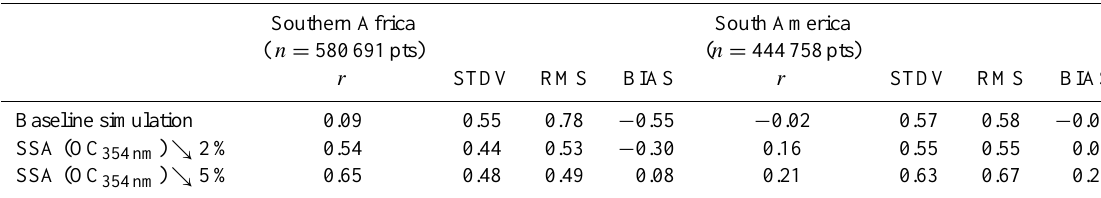
Table 4. Summary of AI comparison between MERRAero and OMI for the period JJA 2007 after a decrease of 2 and 5% of the SSA at 354nm for OC only. The SSA at 388nm stays constant.